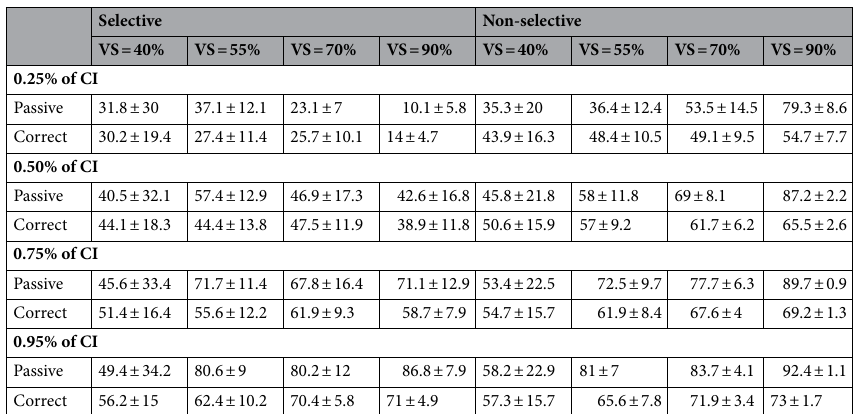
Table 1. The number of single units that can explain 25%, 50%, 75%, and 95% of the maximum CI. The table list the number of single units that can explain X% of the ultimate CI in the passive and correct conditions (rows) for different noisy stimuli of the selective andnon-selective neural populations (column). STD was estimated by bootstrap.